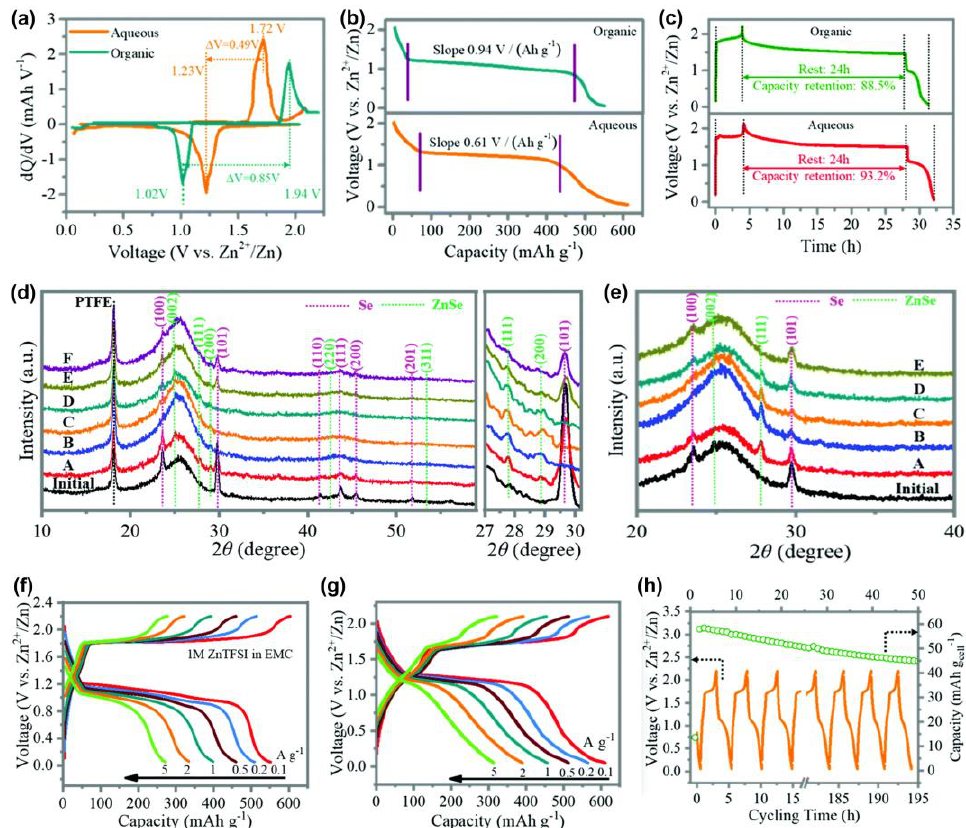
Figure 9. Comparison of ( a ) dQ/dV of the discharge-charge curves, ( b ) plateau slopes, and ( c ) self- discharge behaviors of AZSeBs in organic and aqueous electrolytes; ex situ XRD patterns of AZSeBs in ( d ) organic and ( e ) aqueous electrolytes; GCD curves of AZSeBs at different rates in ( f ) organic and ( g ) aqueous electrolytes; ( h ) cycling performance of the pouch cell (reproduced with permission from Ref. [65]. Copyright 2021, Royal Society of